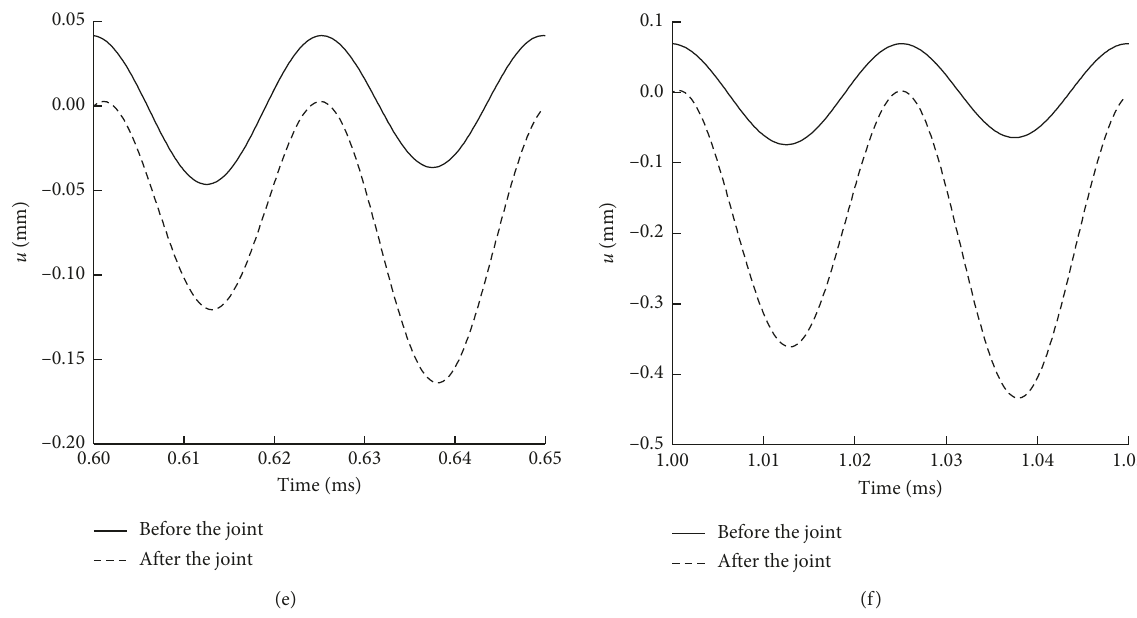
Figure 5: Waveforms recorded before and after the joint at different distances. (a) x 3 . 0m, and (f) x 1 (e) x 1 (cid:31)